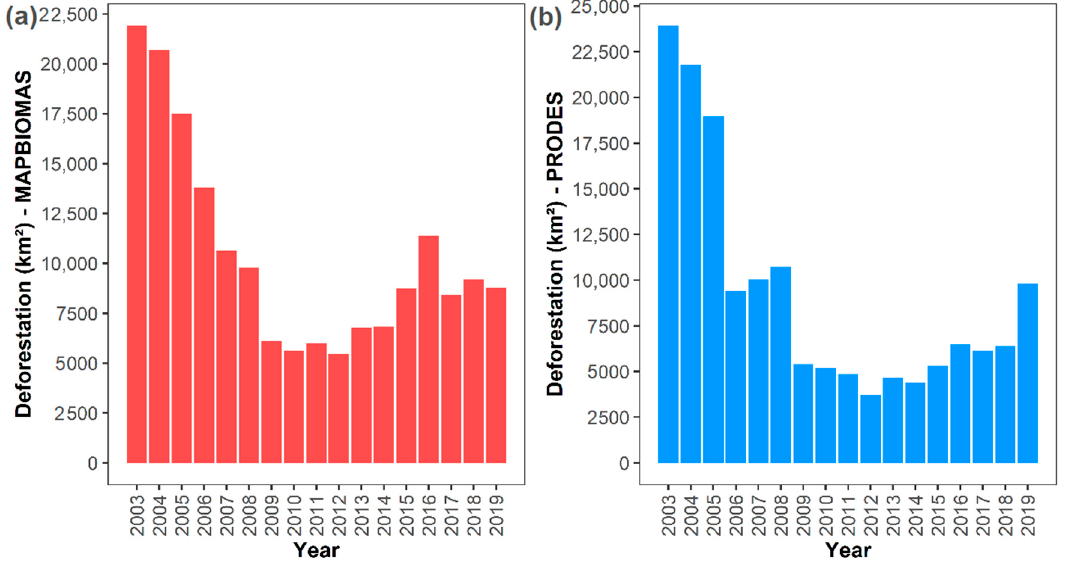
Figure A2. Annual deforestation rates in the study area: ( a ) Mapbiomas Primary and Secondary Vegetation. ( b ) PRODES.